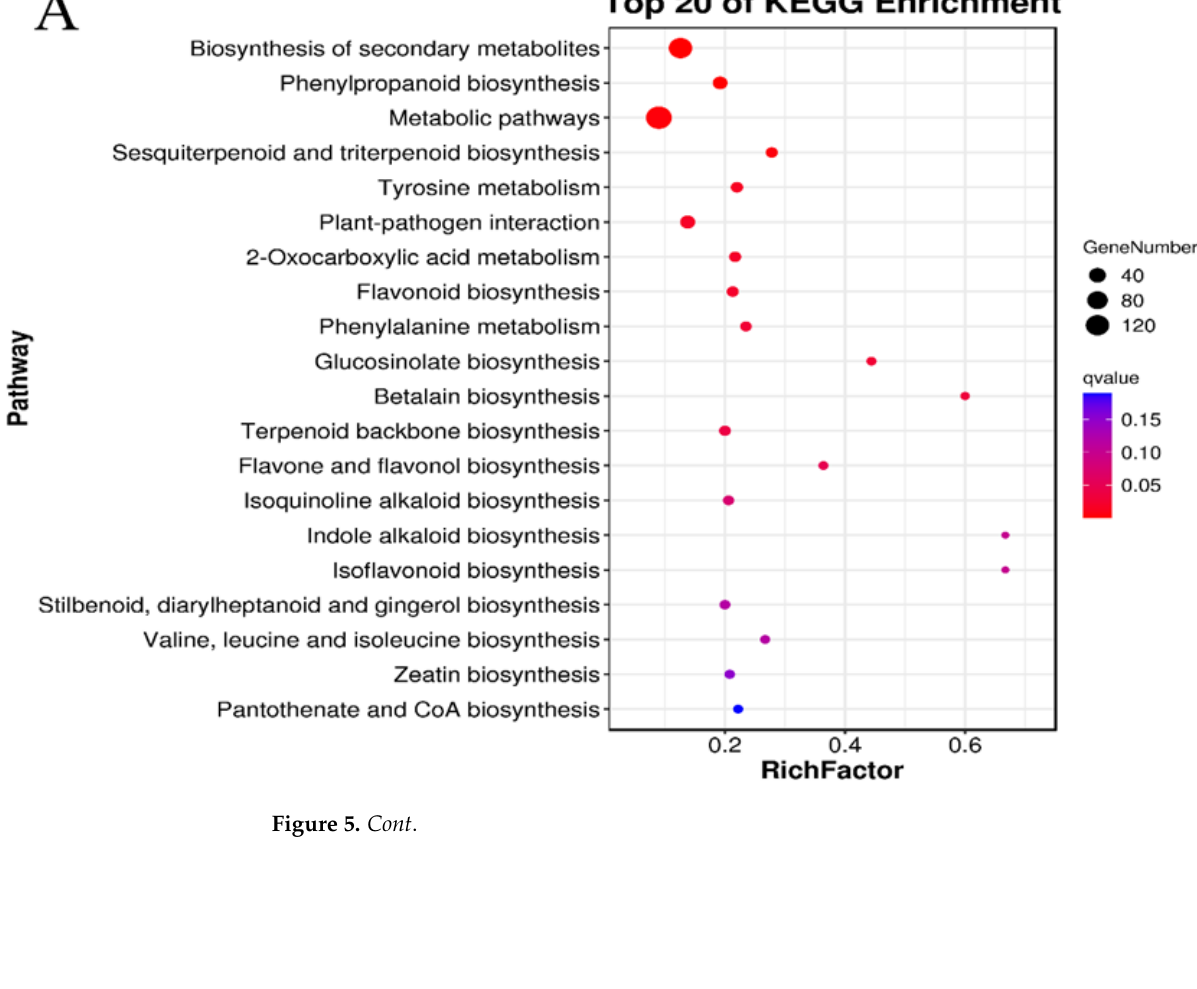
Figure 5. Enrichment Analysis of Differentially Expressed Genes (DEGs) Involved in the Metabolic Pathways Altered in Treated Leaves and Stems via the KEGG Database. (A)-(B), two charts show enriched metabolisms altered in treated leaves (C-Y) ( A ) and stems (C-J) ( B ). The KEGG enrichment bubble diagrams indicate that the top 20 enriched metabolisms with the smallest Q value. The ordi- nate includes plant metabolisms. The abscissa is the enrichment factor (the number of DEGs in the pathway divided by all the numbers in the pathway). Bubble size indicates the quantity. The color code from blue to red indicates the trend from the biggest to smallest Q values. KEGG, Kyoto Ency- clopedia of Genes and Genomes.